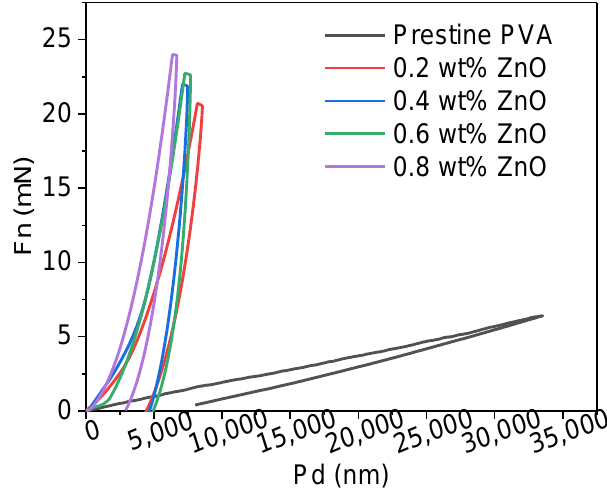
Figure 11. Nanoindentation curve of PVA/ZnO films plotted against force vs. displacement, with 0.2 wt% ZnO indicated by the red line, ZnO with 0.4 wt% indicated by the blue line, ZnO with 0.6 wt% indicated by the green line, and ZnO with 0.8 wt% indicated by the purple line. While simple PVA film is indicated by black line.